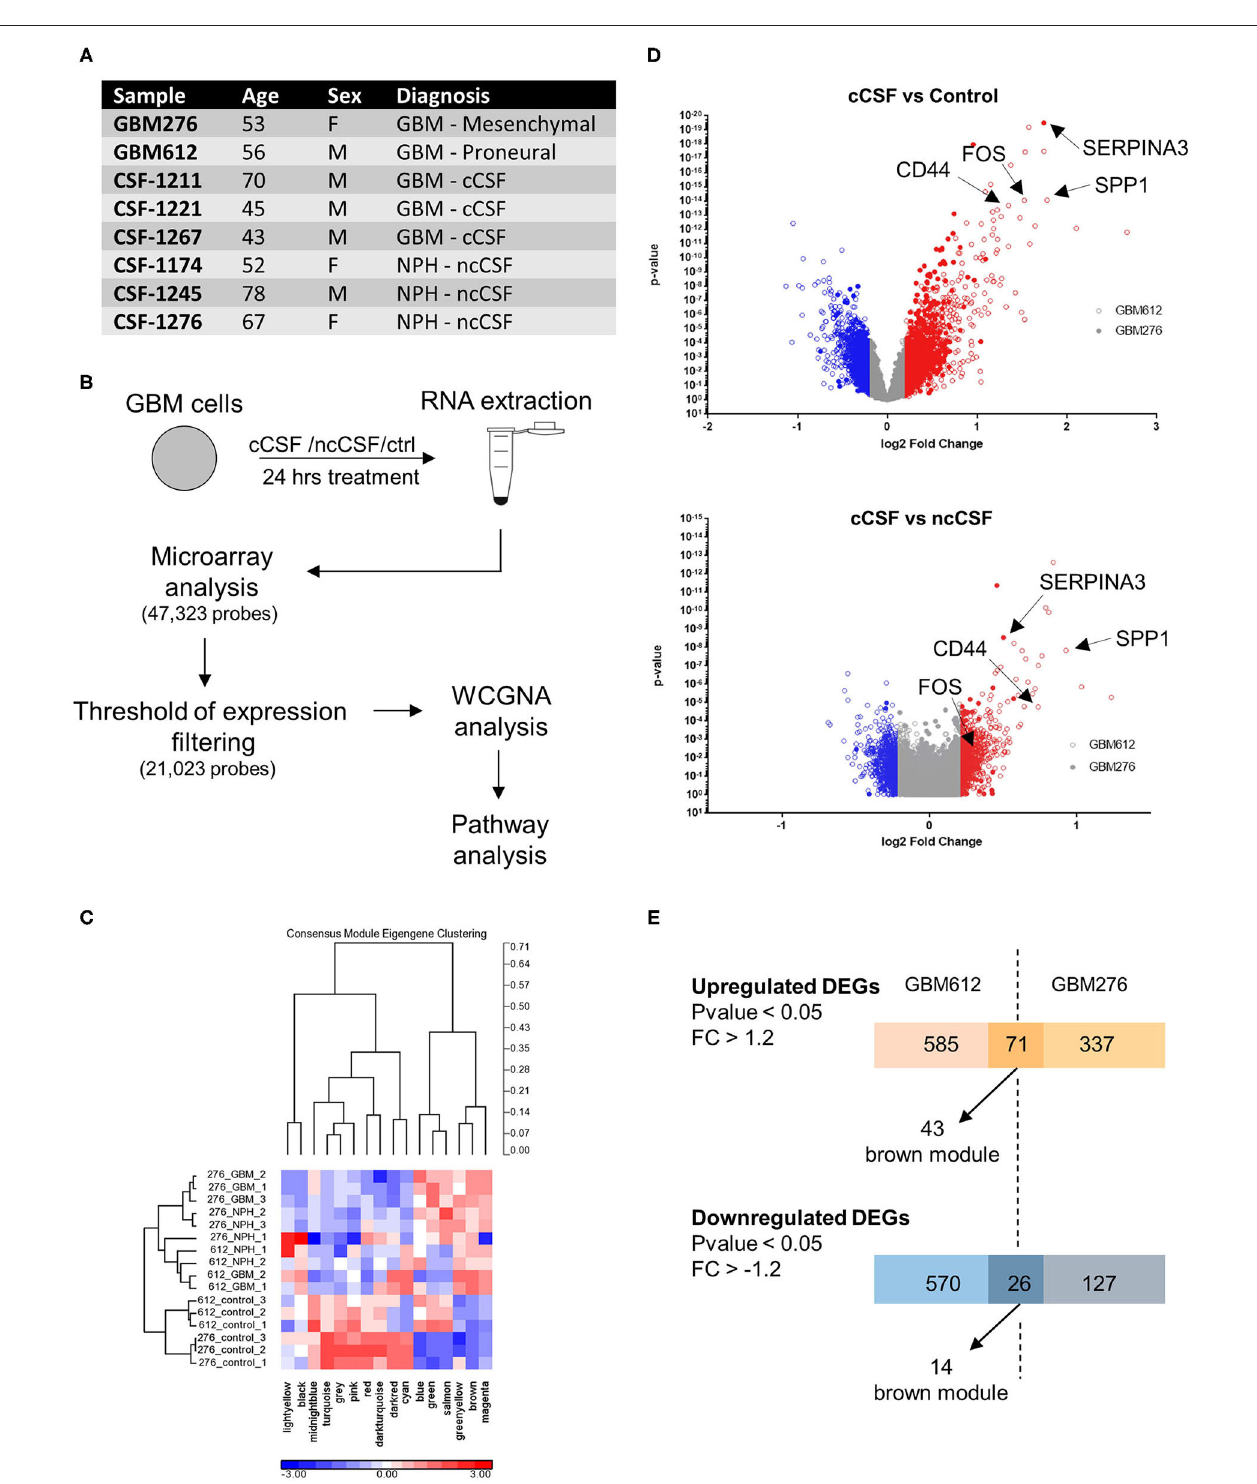
FIGURE 1 | RNA expression microarray WGCNA analysis. (A) Demographic data of samples utilized for RNA expression analysis. (B) Schematic of the experiment. Cells were cultured for 24h in the presence of cCSF or ncCSF then processed for RNA extraction and microarray analysis. (C) With a Weighted Gene Co-expression Network Analysis (WCGNA) we identify 16 modules of highly correlated genes, of which 10 reached significancy. (D) Volcano plot showing the expression levels of the transcripts derived from the 2 cell lines analyzed. GBM276 is represented by diamonds, GBM612 is represented by circles. (E) Venn diagrams showing unique and common DEGs between the 2 BTICs cells used for analysis (GBM612 and GBM276). GBM, Glioblastoma; cCSF, cancer derived CSF; ncCSF, non-cancer derived CSF; NPH, normal pressure Hydrocephalus; M, male; F, female.